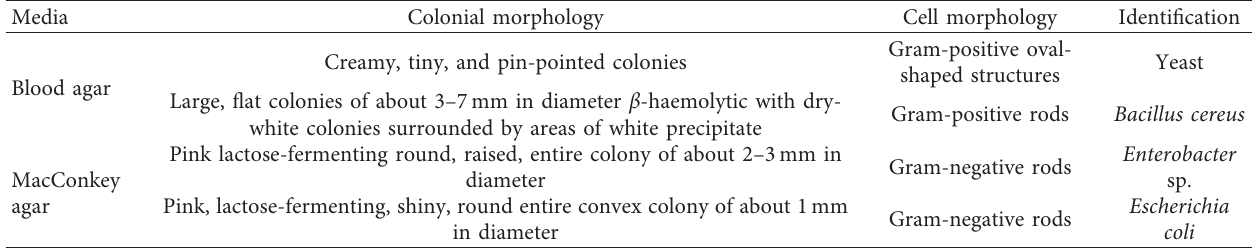
Table 2: Colony and cell morphology of isolates on blood agar and MacConkey agar.